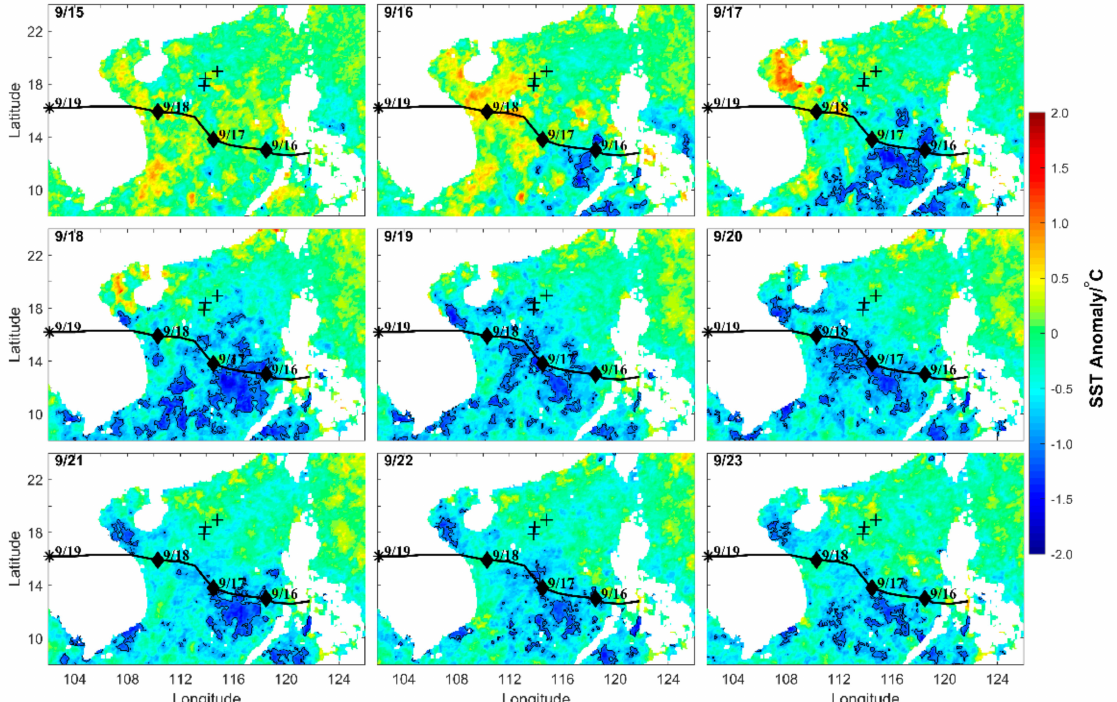
Figure 3. Evolution of SST anomaly from September 15 to 23. The SST anomaly is calculated relative to SST on September 14. The black contours denote –1 ◦ C. The black line and diamonds show the track and center of Noul. The black plus signs denote the three